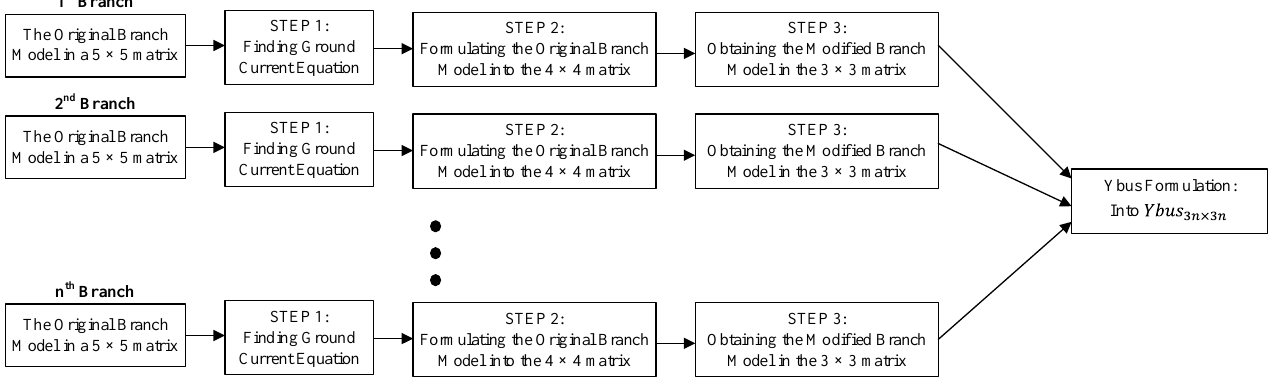
Figure 5. The flowchart of Ybus formulation.